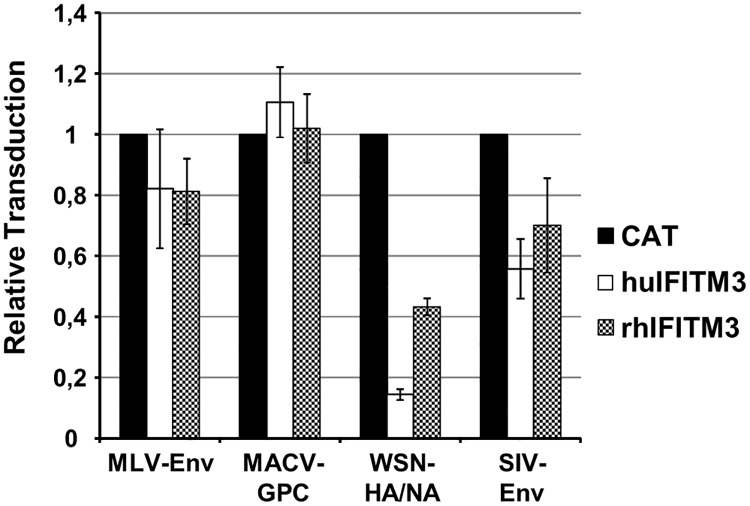
Rhesus macaque IFITM3 exerts antiviral activity.293T cells expressing human (hu) and rhesus macaque (rh) IFITM3 or chloramphenicol-acetyltransferase (CAT) as negative control were transduced with MLV particles encoding luciferase and harboring the indicated viral glycoproteins. Luciferase activities in cell lysates were determined at 72 h post transduction. The average of three to six independent experiments is shown. Luciferase activities measured in control cells were set as 1. Error bars indicate standard error of the mean.